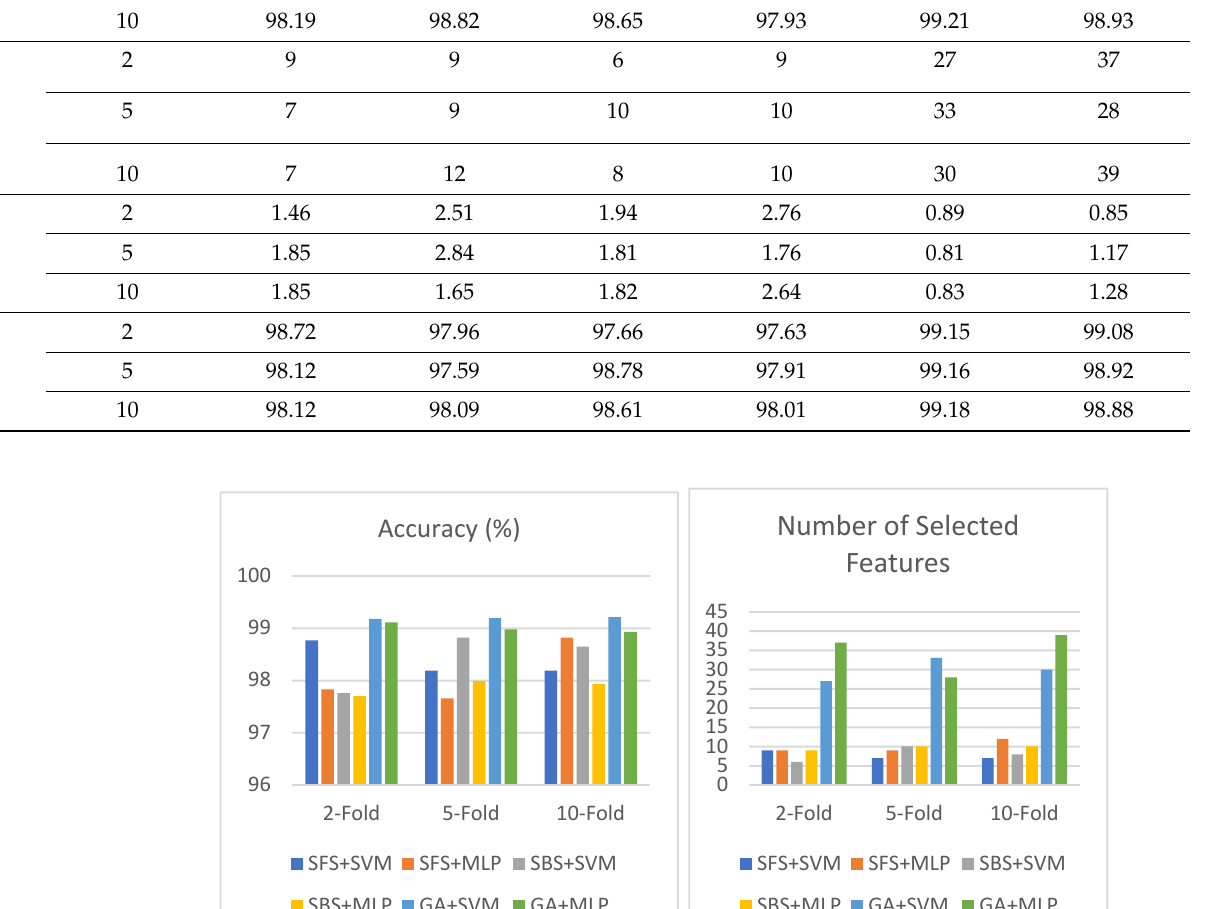
Table 9. Performance of SFS, SBS, and GA using objective function based on DR, FPR, and number of selected features in